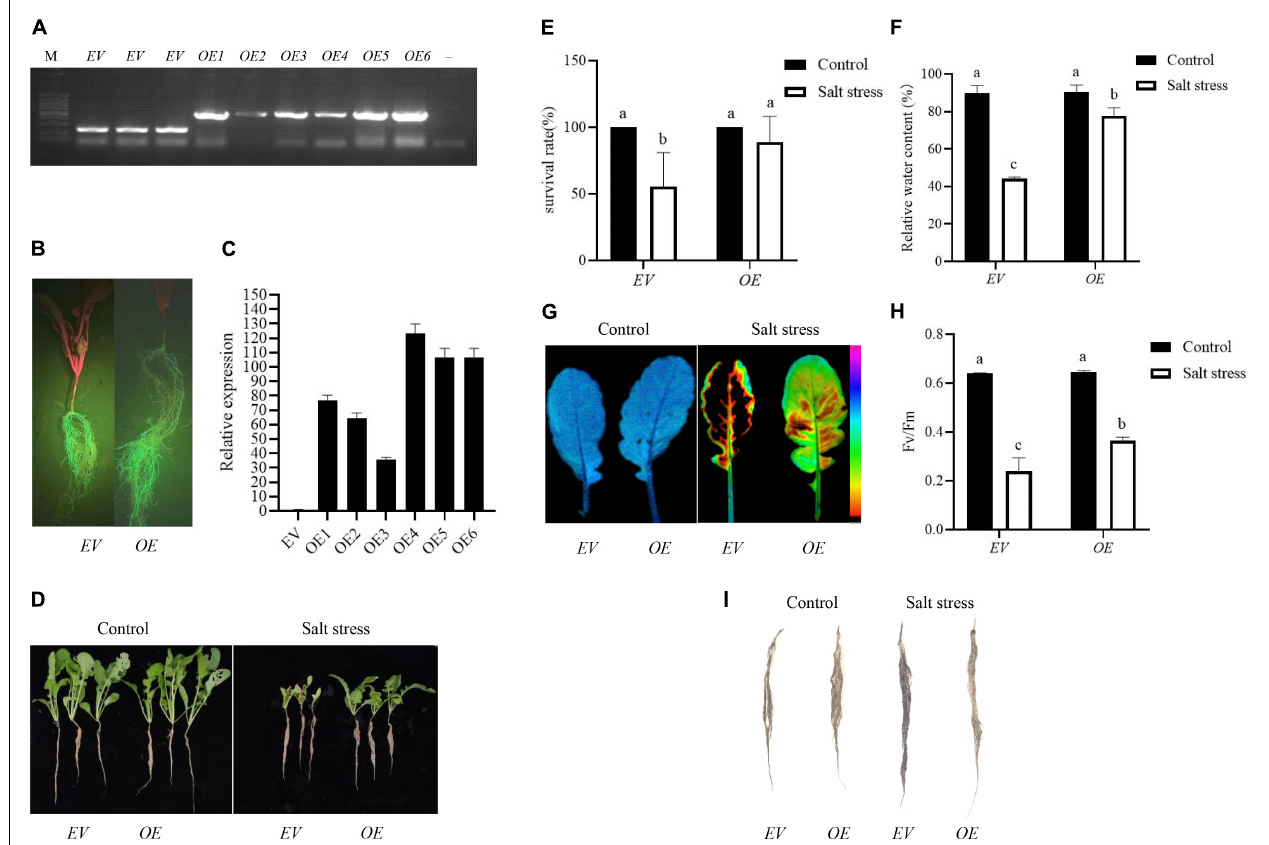
FIGURE 7 | Overexpression of RsPIP2-6 positively regulated salt tolerance in radish. (A) PCR identification of RsPIP2-6 -GFP (1300-GFP-F/ RsPIP2-6 -GFP-R primers) and 1300-GFP (1300-GFP-F/1300-GFP-R primers) in transgenic radish hairy roots. M: DL5000 marker; –, ddH 2 O; EV : radish hairy root containing empty vector (pCambia1300-GFP), OE : radish hairy root overexpressing RsPIP2-6 . (B) Green fluorescent protein (GFP) fluorescence in the hairy roots of radish. (C) Relative expression levels of RsPIP2-6 in EV and OEs . (D) Phenotypes of EV and OE seedlings with 0 or 150 mM NaCl (150 mM for 6 days). (E) Statistical analysis of the survival rates of EV s and OE s with 0 or 150 mM NaCl. (F) Relative water content of EV s and OE s in radish with 0 or 150 mM NaCl. (G) Lipid peroxidation visualized by autoluminescence imaging. The color palette indicated luminescence intensity from low (purple) to high (black) values. (H) Fv/Fm rate in EV s and OE s radish with 0 or 150 mM NaCl. (I) Histochemical staining with NBT in the hairy roots of radish EVs and OEs with 0 or 150 mM NaCl. Each bar shows the mean ± SE of the triplicate assay, values with different lowercase letters indicate a significant difference at p < 0.05 according to Duncan’s multiple range